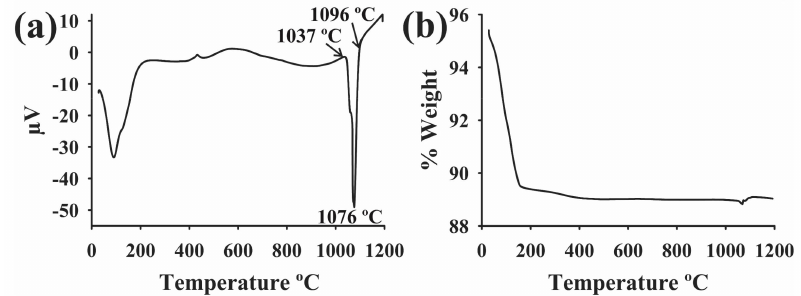
Figure 1. BNi-9: ( a ) heat flow curve obtained by di ff erential scanning calorimetry; and ( b ) thermogravimetric curve.